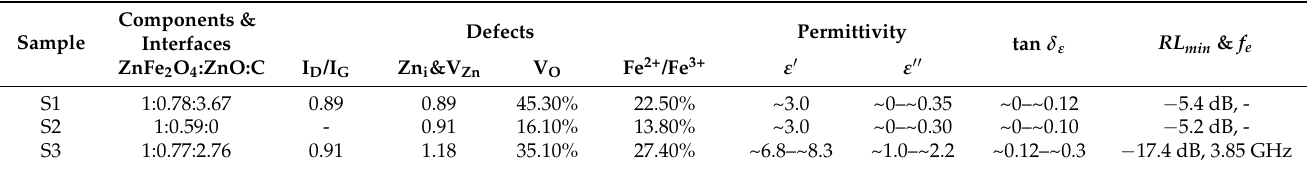
Table 1. Components, defects, permittivity, dielectric loss and EMW absorption performance of S1–S3.